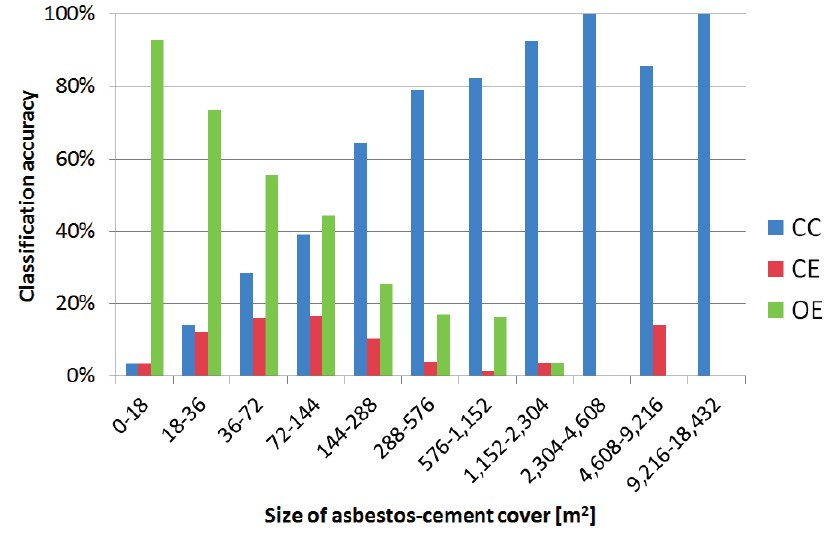
Figure 6. Correct detection and classification errors vs. the size of the asbestos-cement roofs. CC: correct classification, OE: omission error, CE: commission